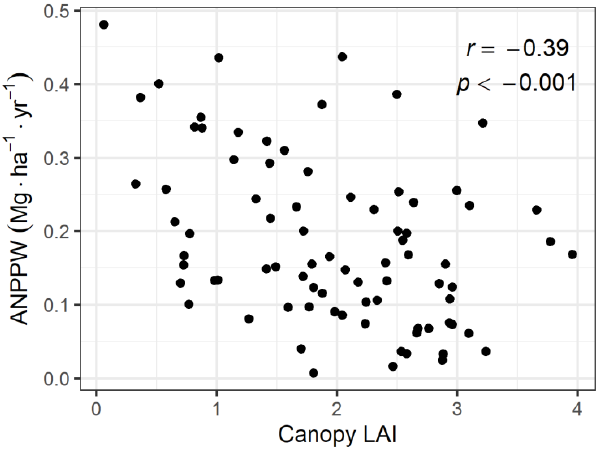
Figure 6. The relationship between canopy LAI and ANPPW in each subplot. Each point indicates one subplot (n = 81).